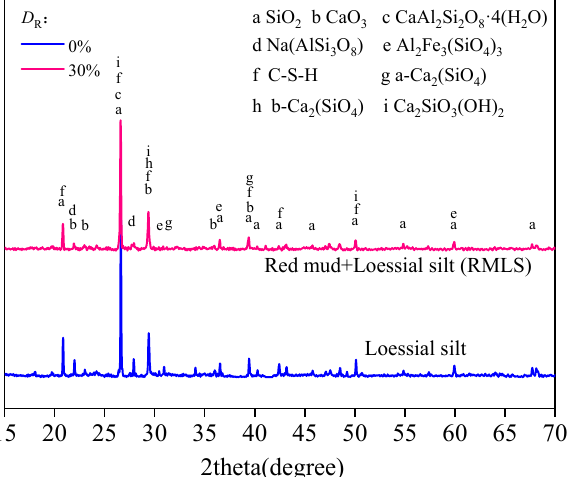
Figure 23. XRD pattern of loessial silt and RMLS for a curing time of 28 days.